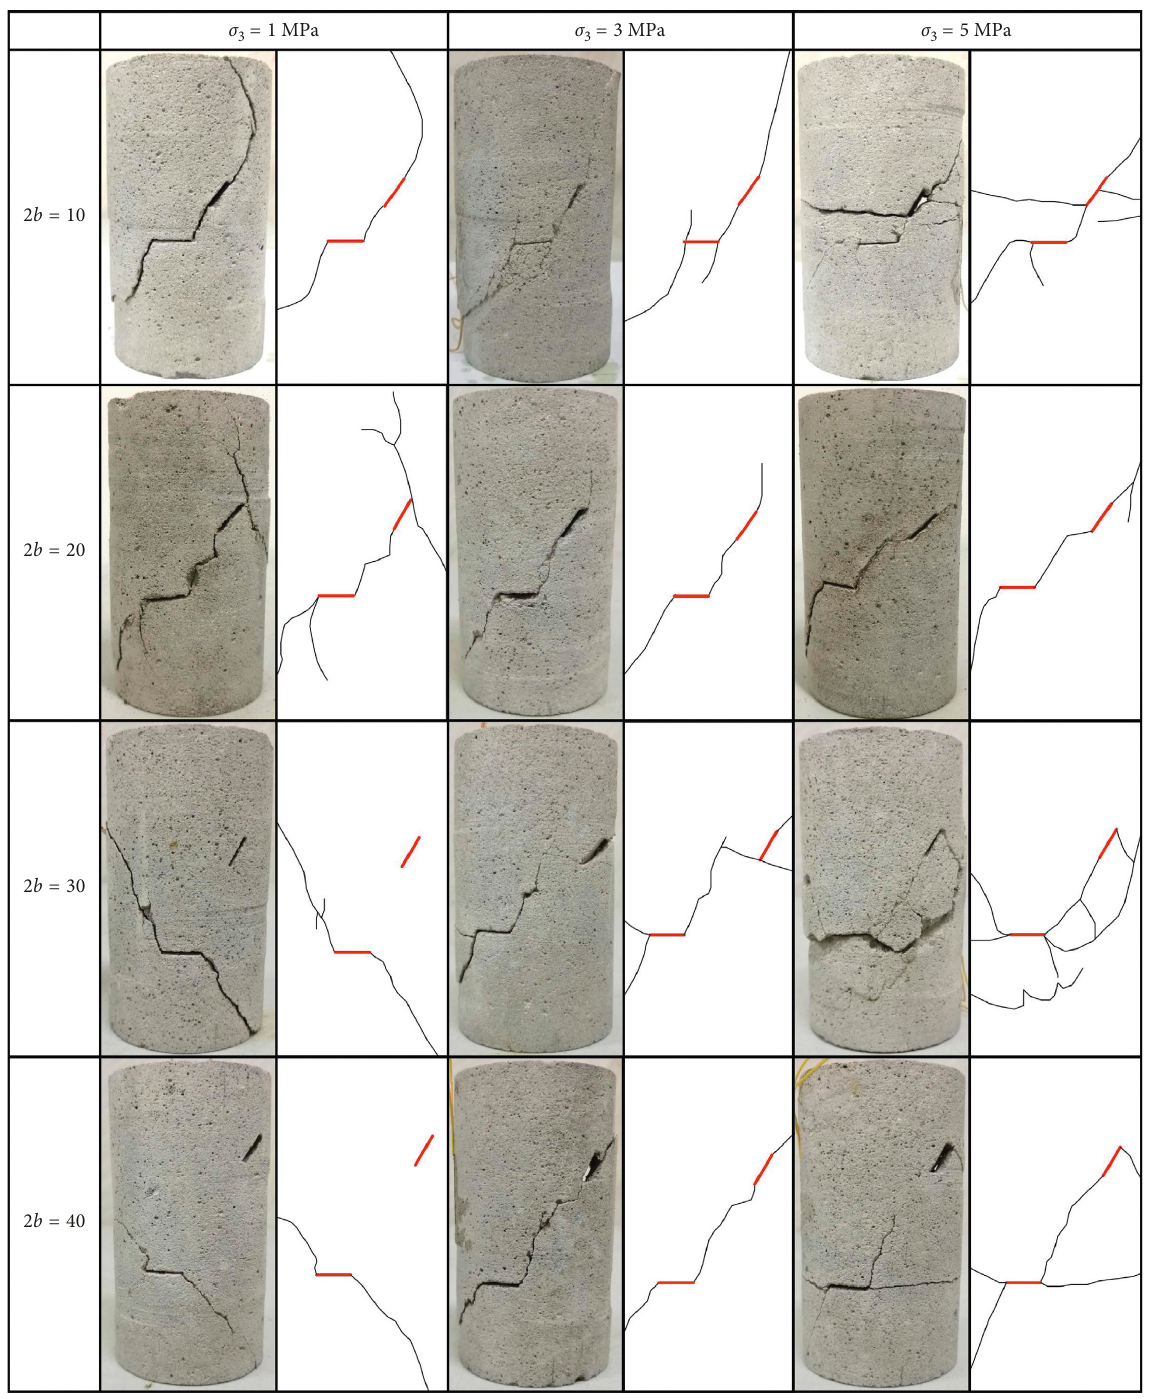
Figure 5: Failure modes of the specimens with a geometry of 2 b -0-60-60 but with different bridge